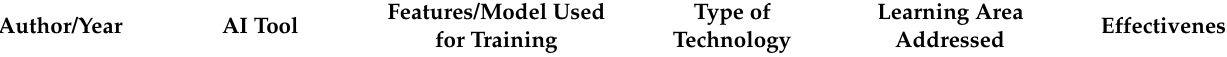
Table 5. Review of AI assistive tools used to address learning disabilities of students with